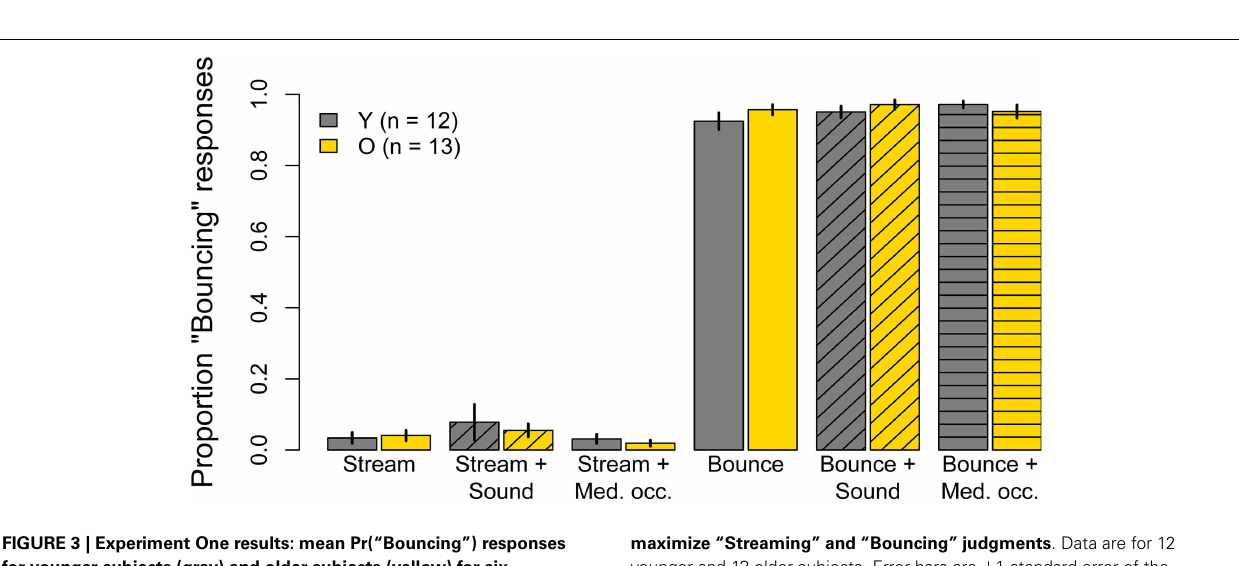
FIGURE 3 | Experiment One results: mean Pr(“Bouncing”) responses for younger subjects (gray) and older subjects (yellow) for six conditions in which disk luminances had been unbalanced in order to